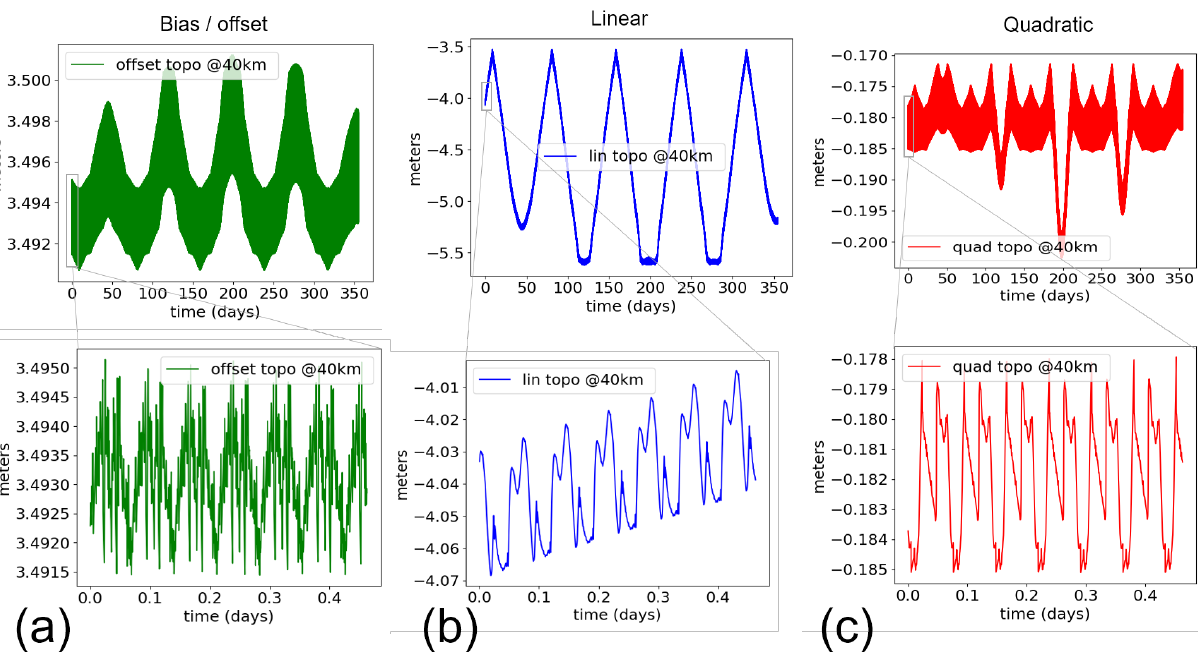
Figure 7. Breakdown of the systematic topography errors from the KaRIn instrument STOP21 simulations (unit: meter RMS). Panel ( a ) is the bias per swath (timing/group delay error). Panel ( b ) is for the linear component (instrument roll knowledge plus phase errors). Panel ( c ) is for the quadratic component (interferometric baseline length error). For each panel, the top figure shows the uncalibrated error as a function of time over one year, and the bottom figure is a zoom over a period of 11 h (13